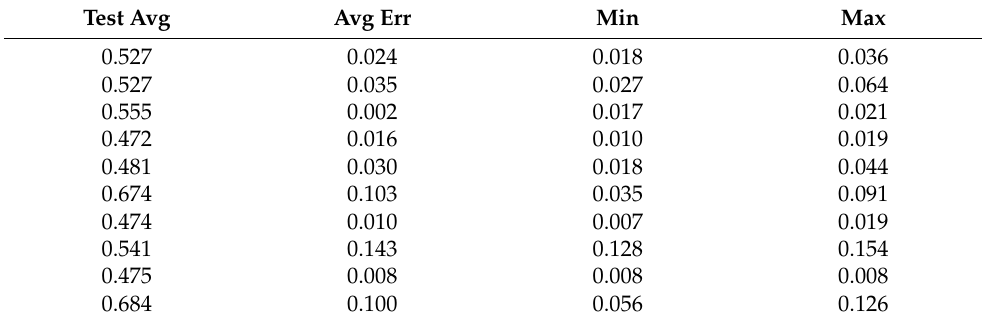
Table A51. Set 1, trials 31–40 data (0.5 PR value).